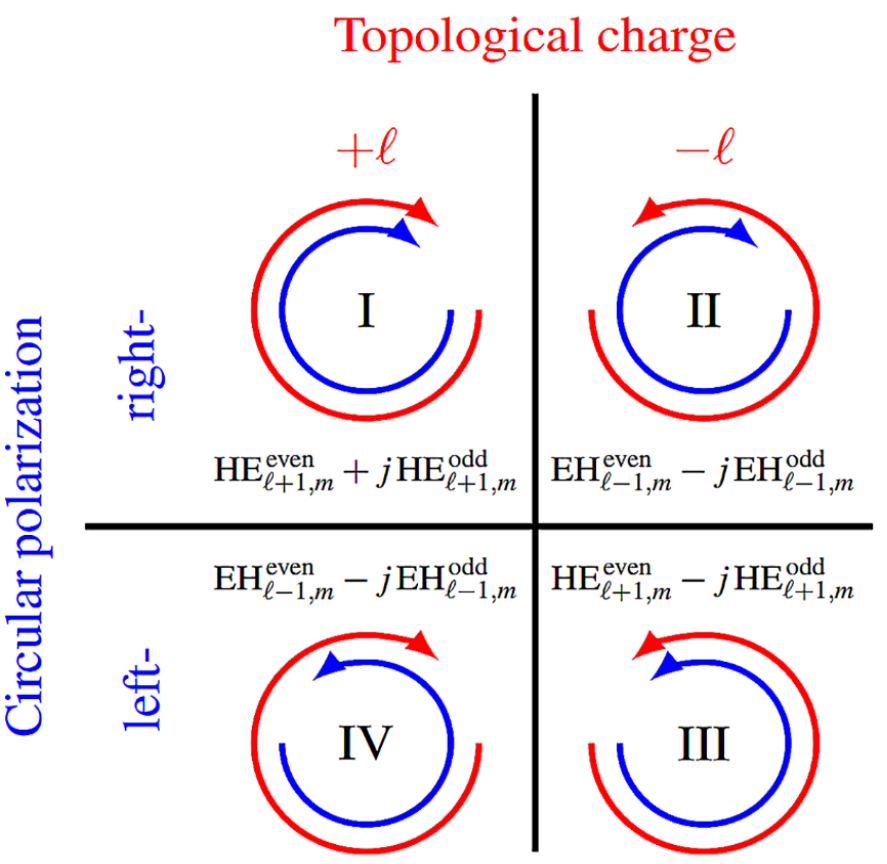
Figure 1. Four OAM beam representations with the same topological charge [23].